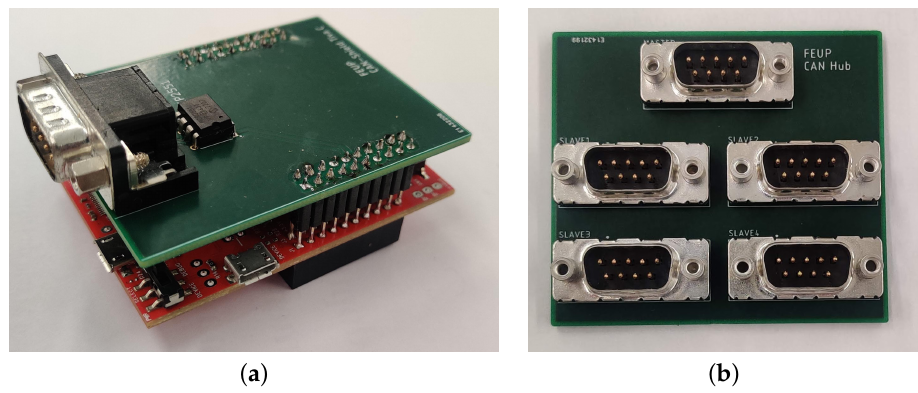
Figure 8. Final PCBs: ( a ) CAN shield PCB assembled; ( b ) CAN hub PCB